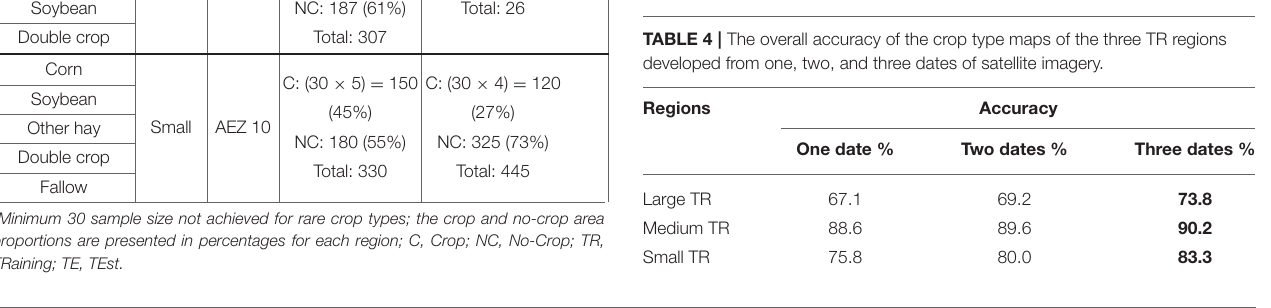
TABLE 3 | The error matrices of the crop / no-crop maps of TR and TE regions for the large, medium, and small field sizes. Large field size